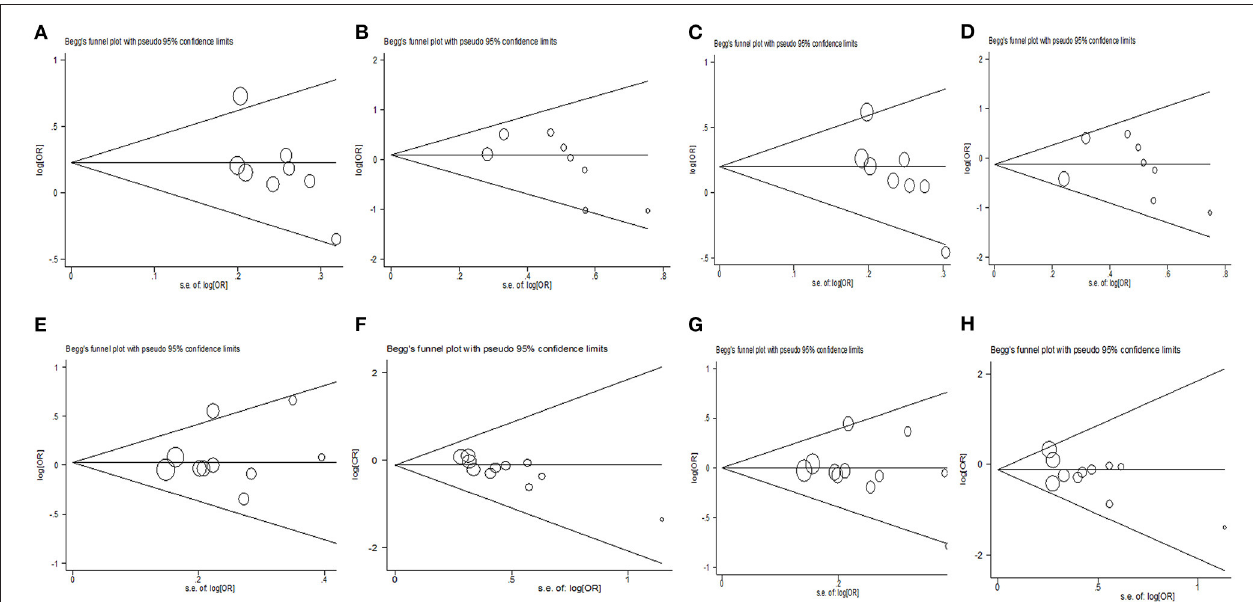
FIGURE 3 | Egger’s funnel plot for publication bias test of HTR1B rs6296 polymorphism with MDD (A–D) and suicidal behavior (E–H) . (A,E) GC vs. GG; (B,F) CC vs. GG; (C,G) GC/CC vs. GG; (D,H) CC vs.